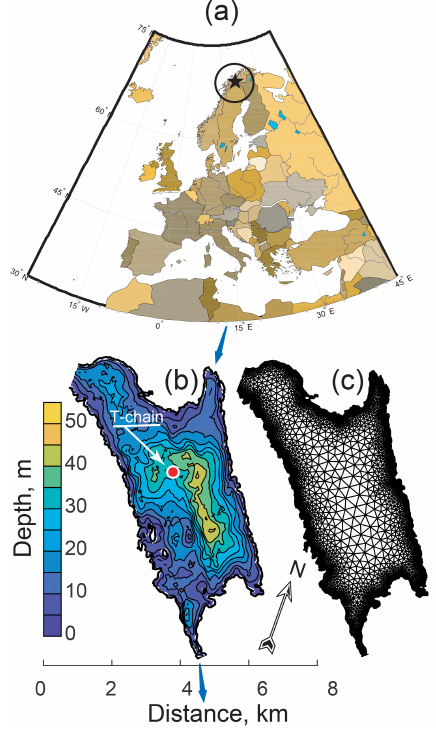
Figure 1. (a) Geographical location of the study site, (b) bathymet- ric map with the position of the thermistor chain, and (c) the grid used in the model of free oscillations. Blue arrows show the river flow